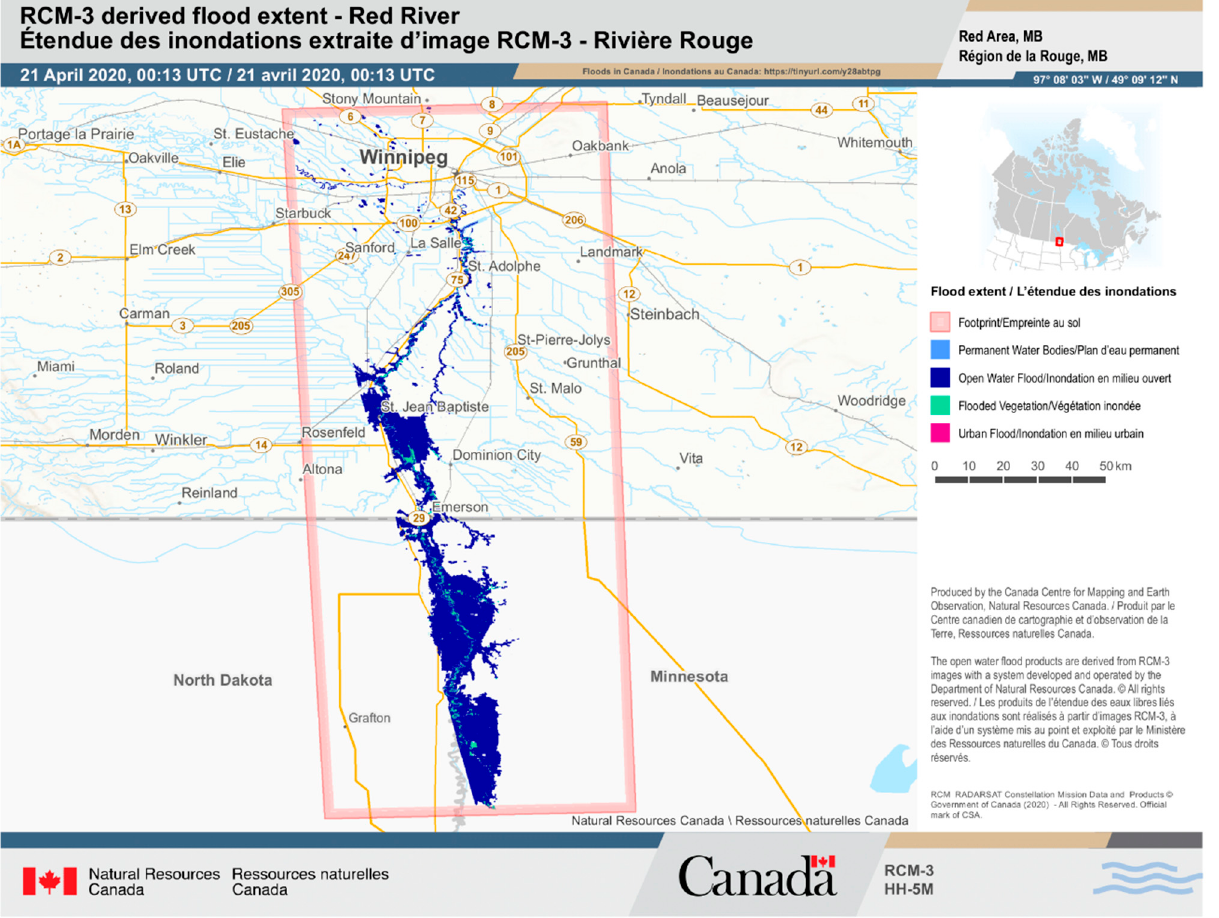
Figure 1. Flood mapping of Red River, Manitoba, using RCM acquisition on 21 April 2020.